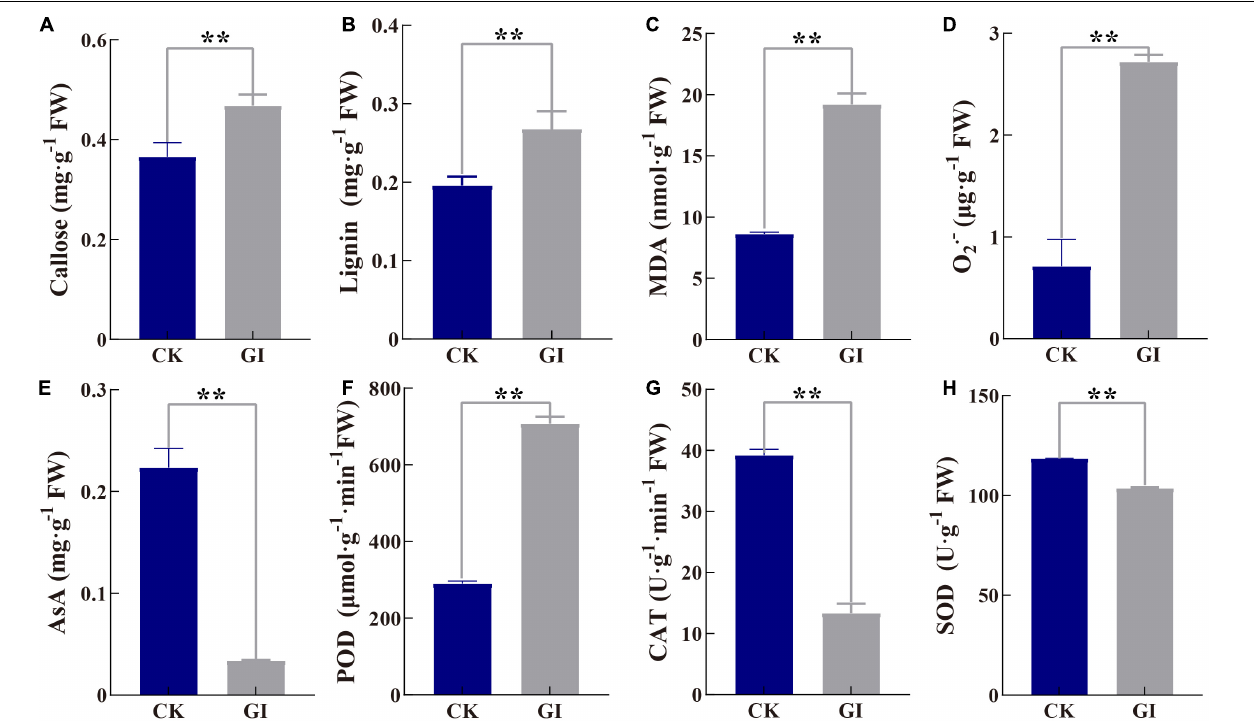
FIGURE 6 | Effects of G. artemisiae infection on callose, lignin, and antioxidant-related indexes in A. selengensis . (A) callose, (B) lignin, (C) malondialdehyde (MDA), (D) superoxide anion (O 2 − ), (E) ascorbic acid (AsA), (F) peroxidase (POD), (G) catalase (CAT), and (H) superoxide dismutase (SOD). Values are means ± SE of three biological replicates. Significant differences were calculated using the unpaired Student’s t -test (** P ≤